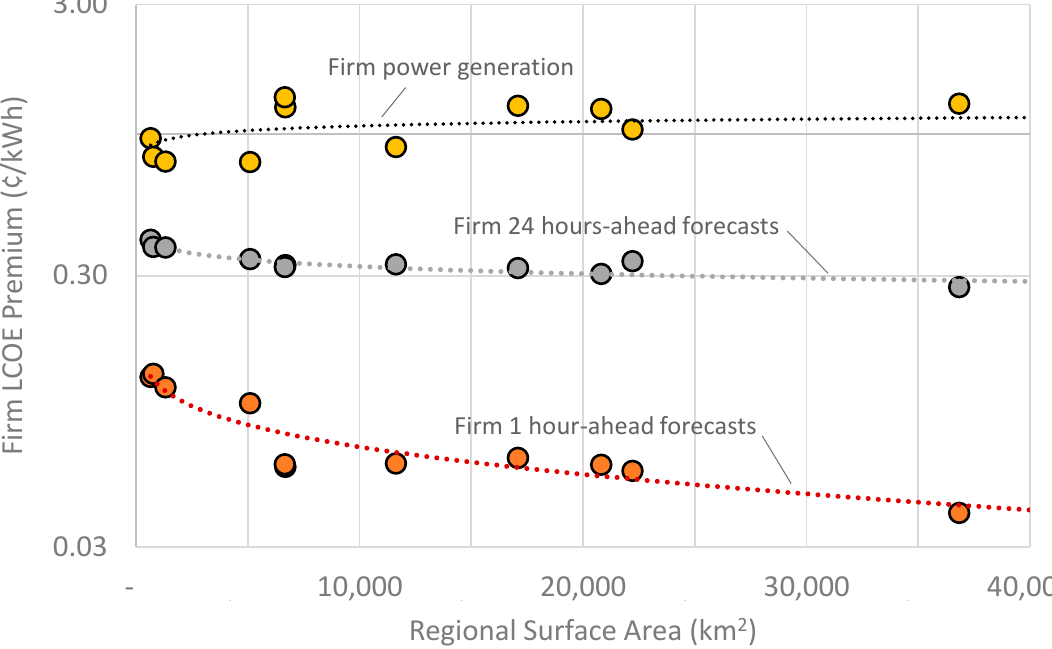
Figure 10. Firm LCOE premium as a function of electrical region size and firm load target.